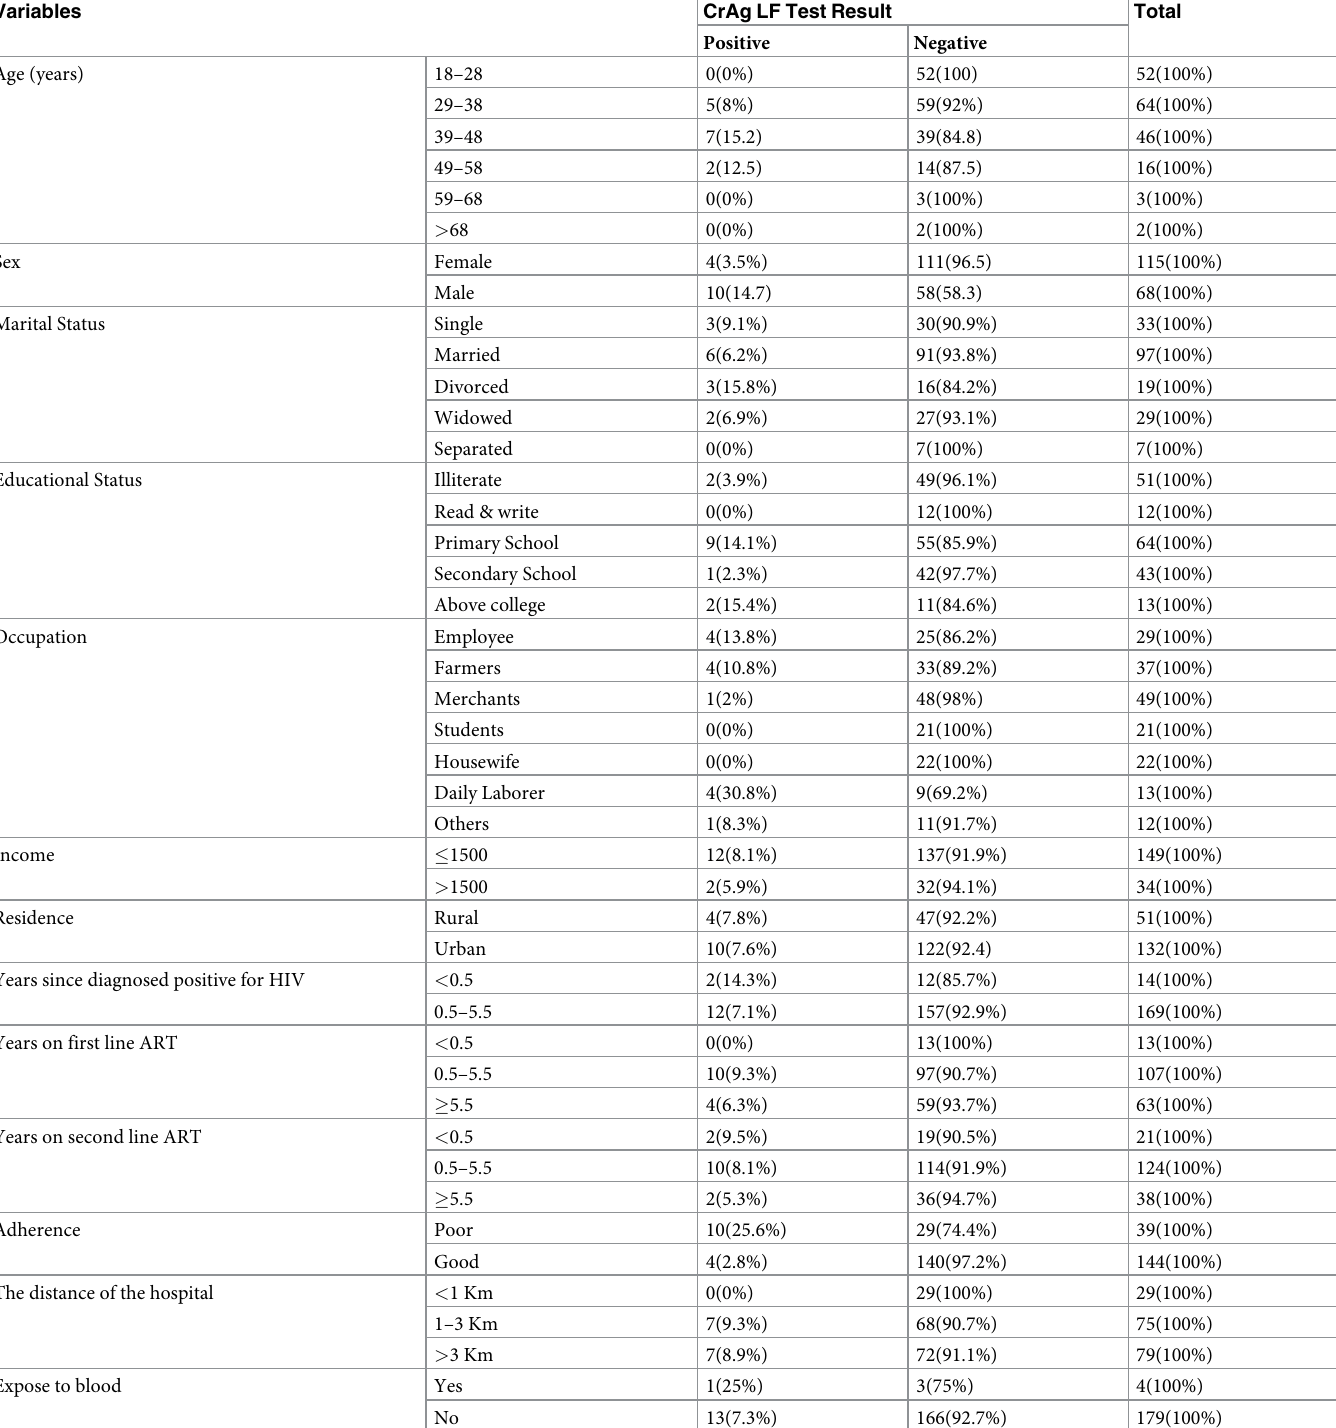
Table 3. Cross-tabulation of CrAg among HIV-infected patients on 2 nd line ART at Ambo General Hospital and Nekemte Referral hospitals, Western Oromia, Ethiopia from September 1 to November 30,